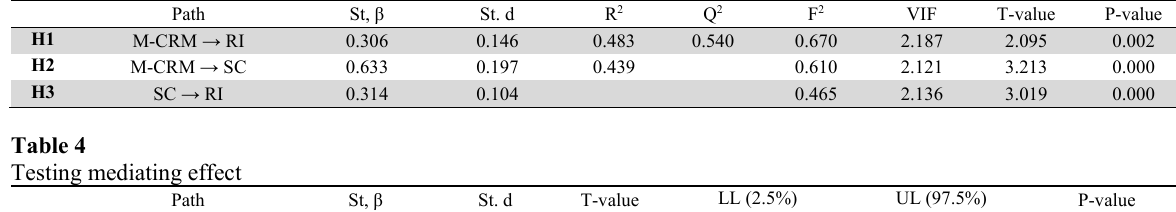
Testing direct relationships